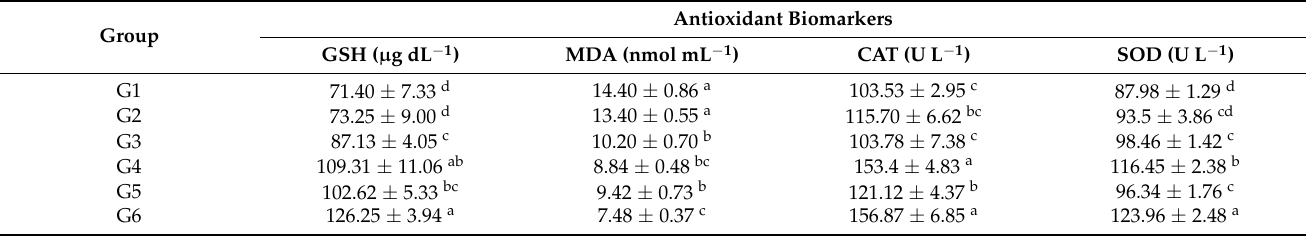
Table 4. Effect of FCM, FCM-D, and IF on oxidative stress biomarkers in obese rats (mean ± SE), n = 8.